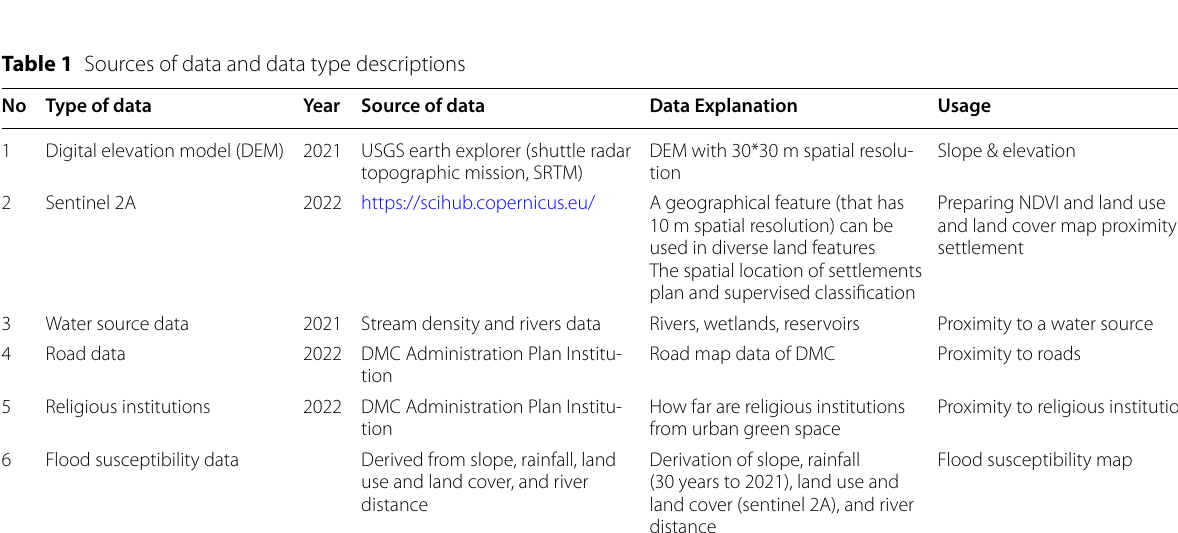
Fig. 1 Location map of DMC